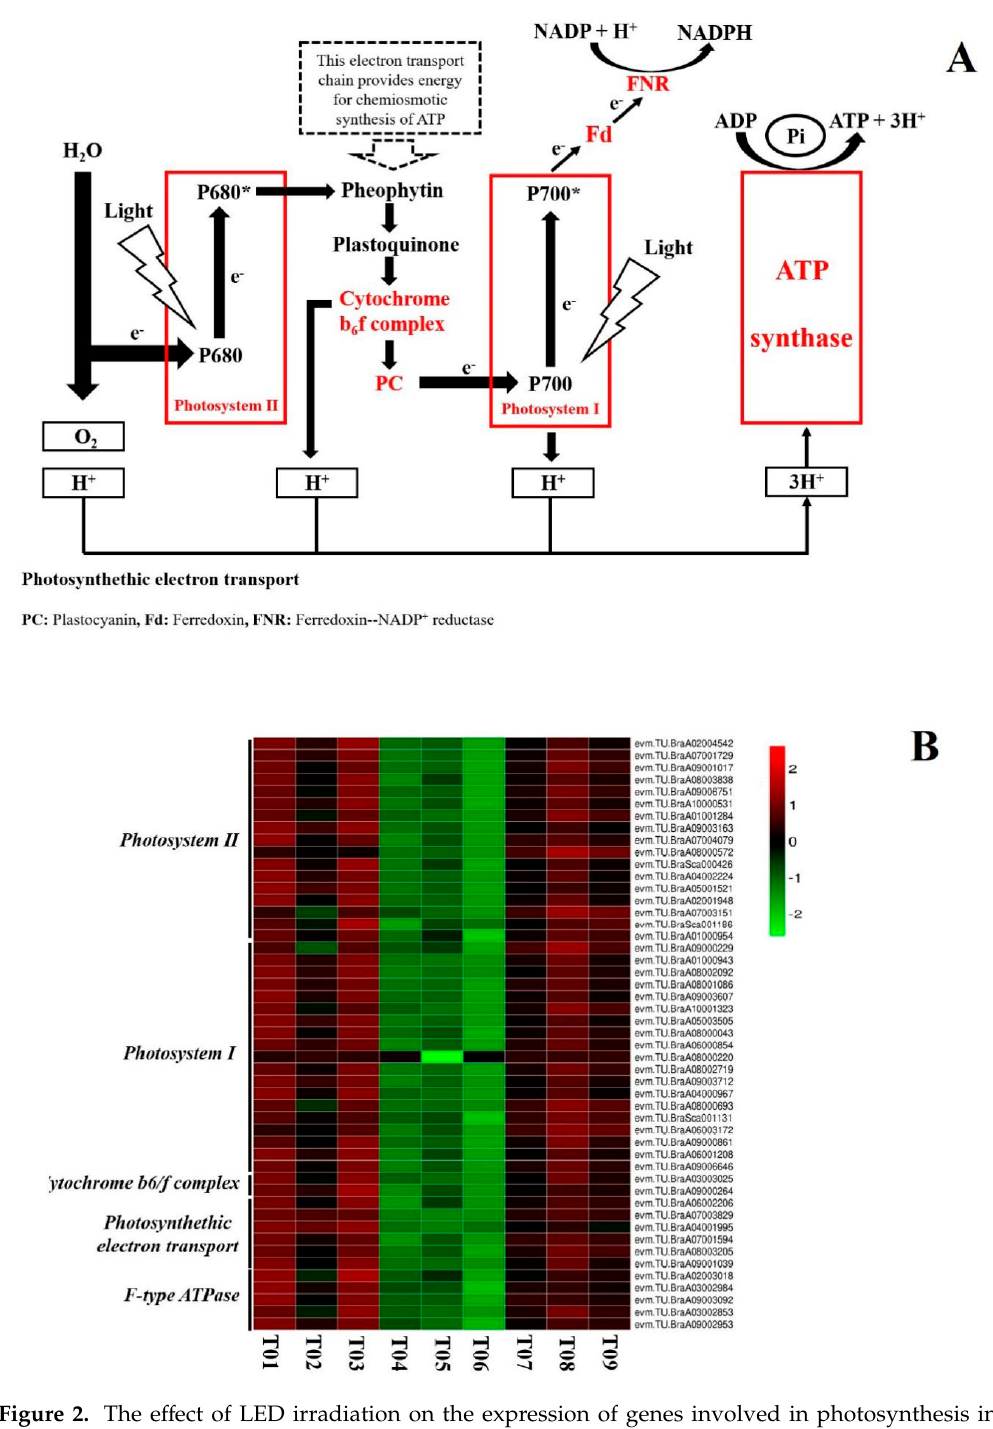
Figure 2. The effect of LED irradiation on the expression of genes involved in photosynthesis in pak-choi. ( A ) Metabolites or genes expressed at a higher level in the LED treatment group, relative to the dark-stored (control) treatment-group, are illustrated in red. Metabolites or genes expressed at a lower level in the LED treatment group, relative to the dark-stored (control) treatment group, are illustrated in green. ( B ) Expression pattern of genes involved in photosynthesis in response to LED irradiation. A total of 49 DEGs (FC ≥ 2; FDR ≤ 0.01) associated with photosynthesis were identified. Log2-based FPKM values were used to generate the heat map. The scale represents the relative signal intensity of FPKM values (T01, T02, T03: initial; T04, T05, T06: dark-stored control 5d; T07, T08, T09: LED 5